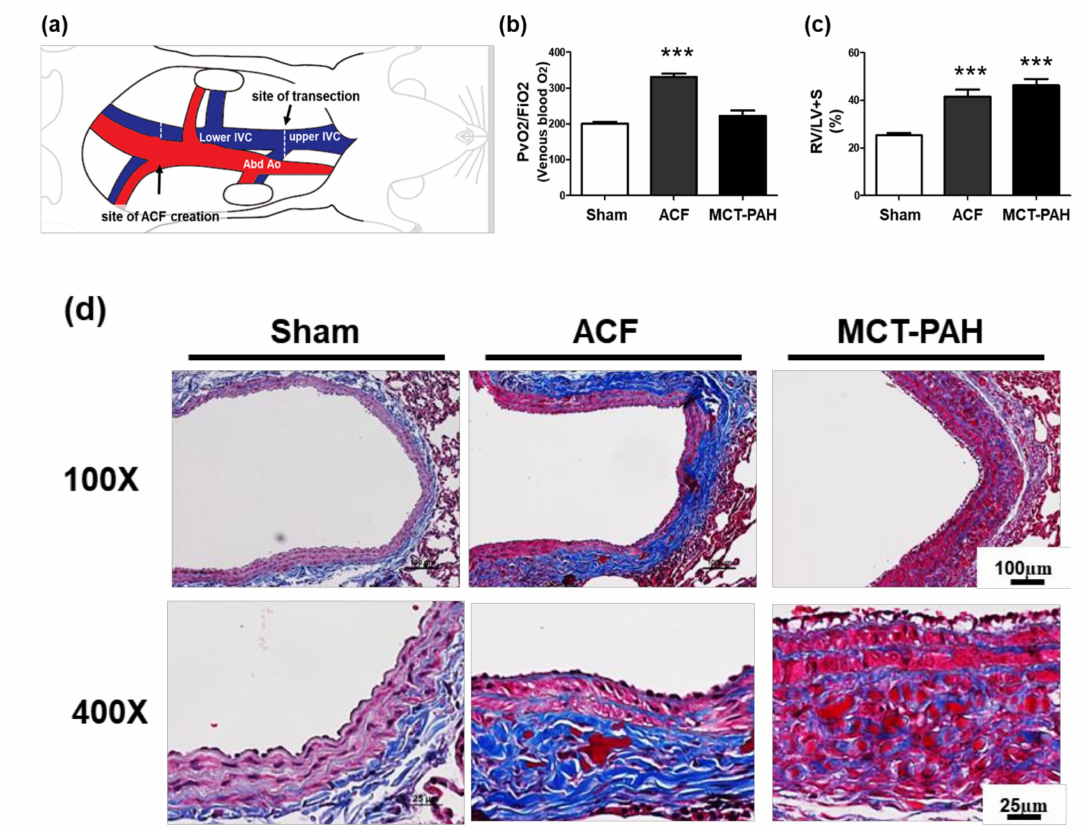
Figure 4. Characterization of the ACF animal model: ACF impacts right heart hypertrophy and collagen accumulation, leading to PA fibrosis. ( a ) A schematic description of the creation of ACF in rats, an experimental model of volume-overload CHF. ( b ) Oxygenation index of the IVC in the sham, ACF and MCT-PAH groups. ( c ) The ratio of RV to LV plus septum weight (RV / LV + S) is shown.